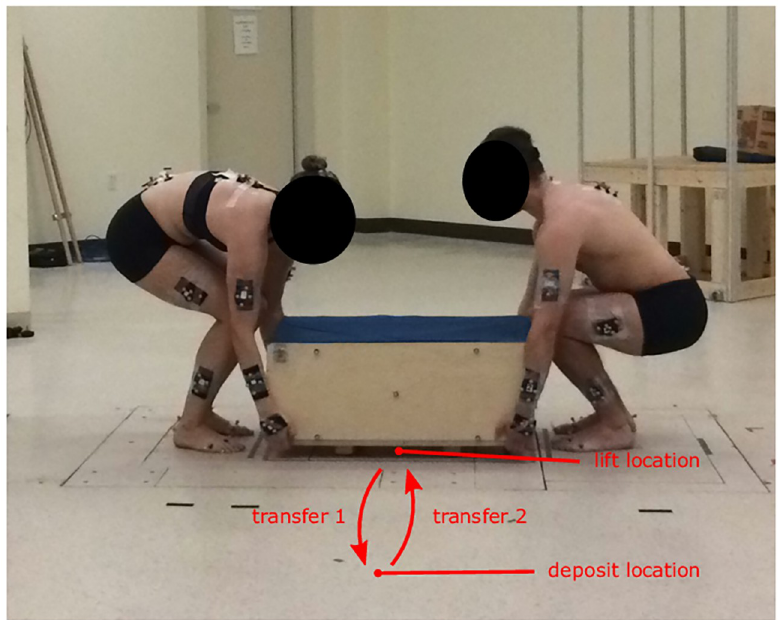
Fig 1. Experimental protocol with two team members lifting the box at the beginning of transfer